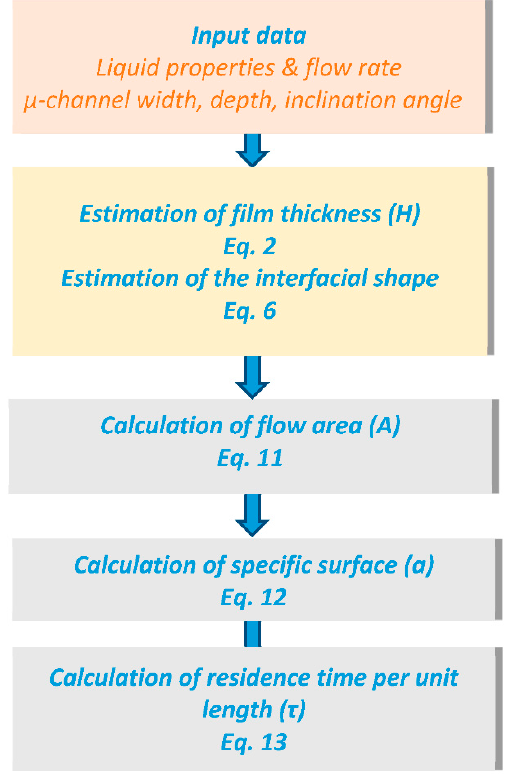
Figure 16. A general strategy for the design of falling film microreactors (FFMRs).